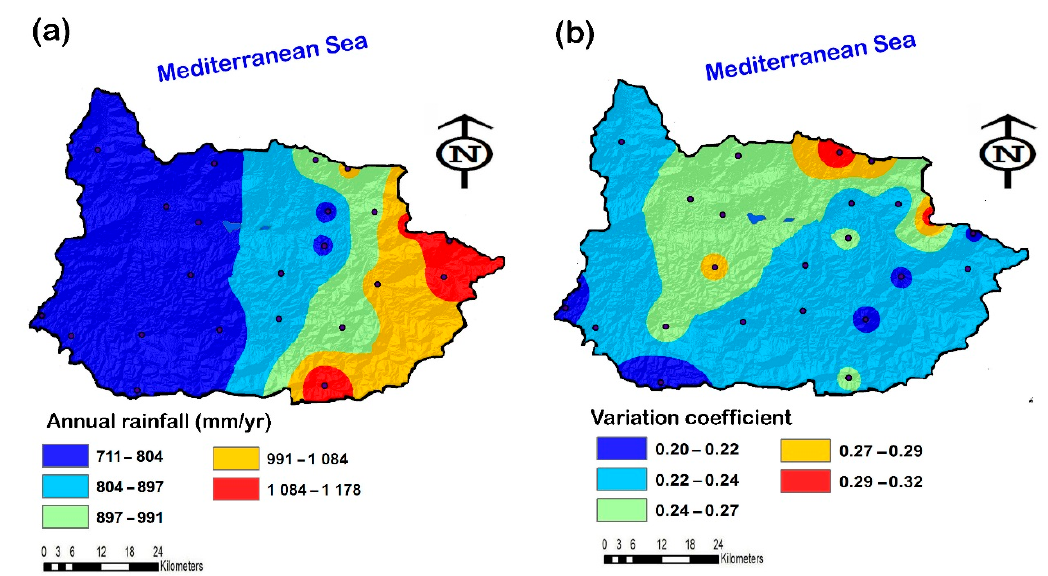
Figure 2. Spatial analysis of ( a ) the average intra-annual rainfall and ( b ) coefficient of variation between 1972–2010 for the study area.